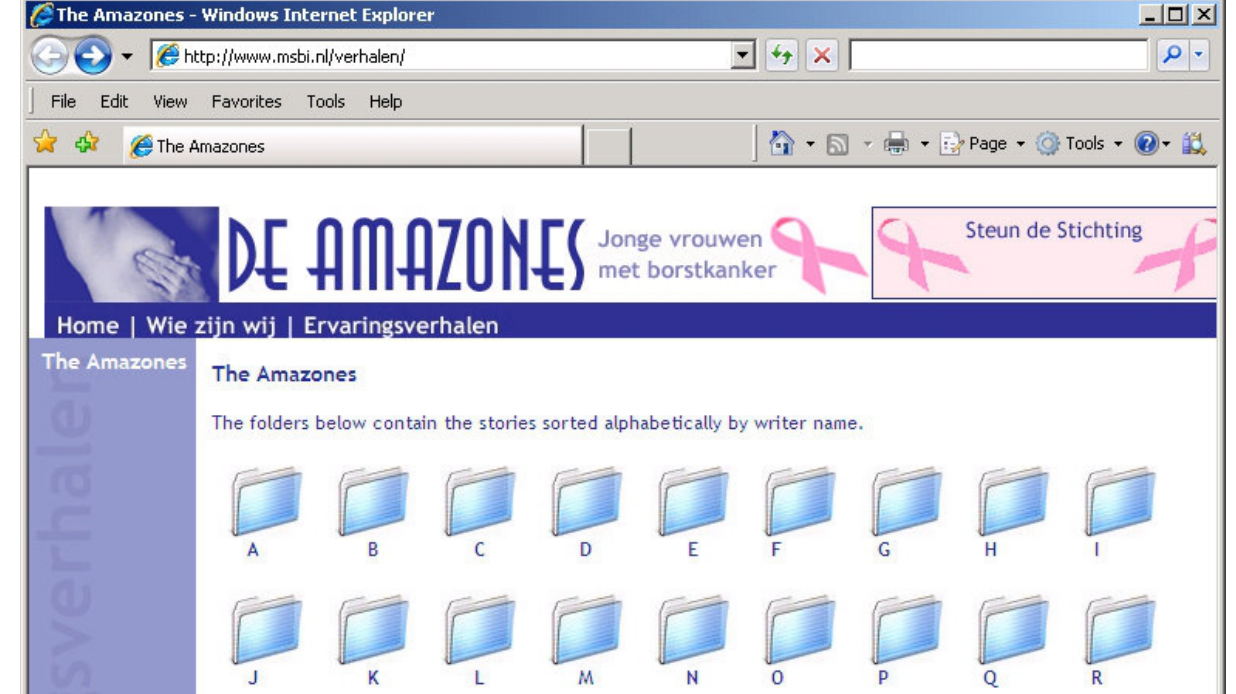
Figure 1. Screenshot of the control group search